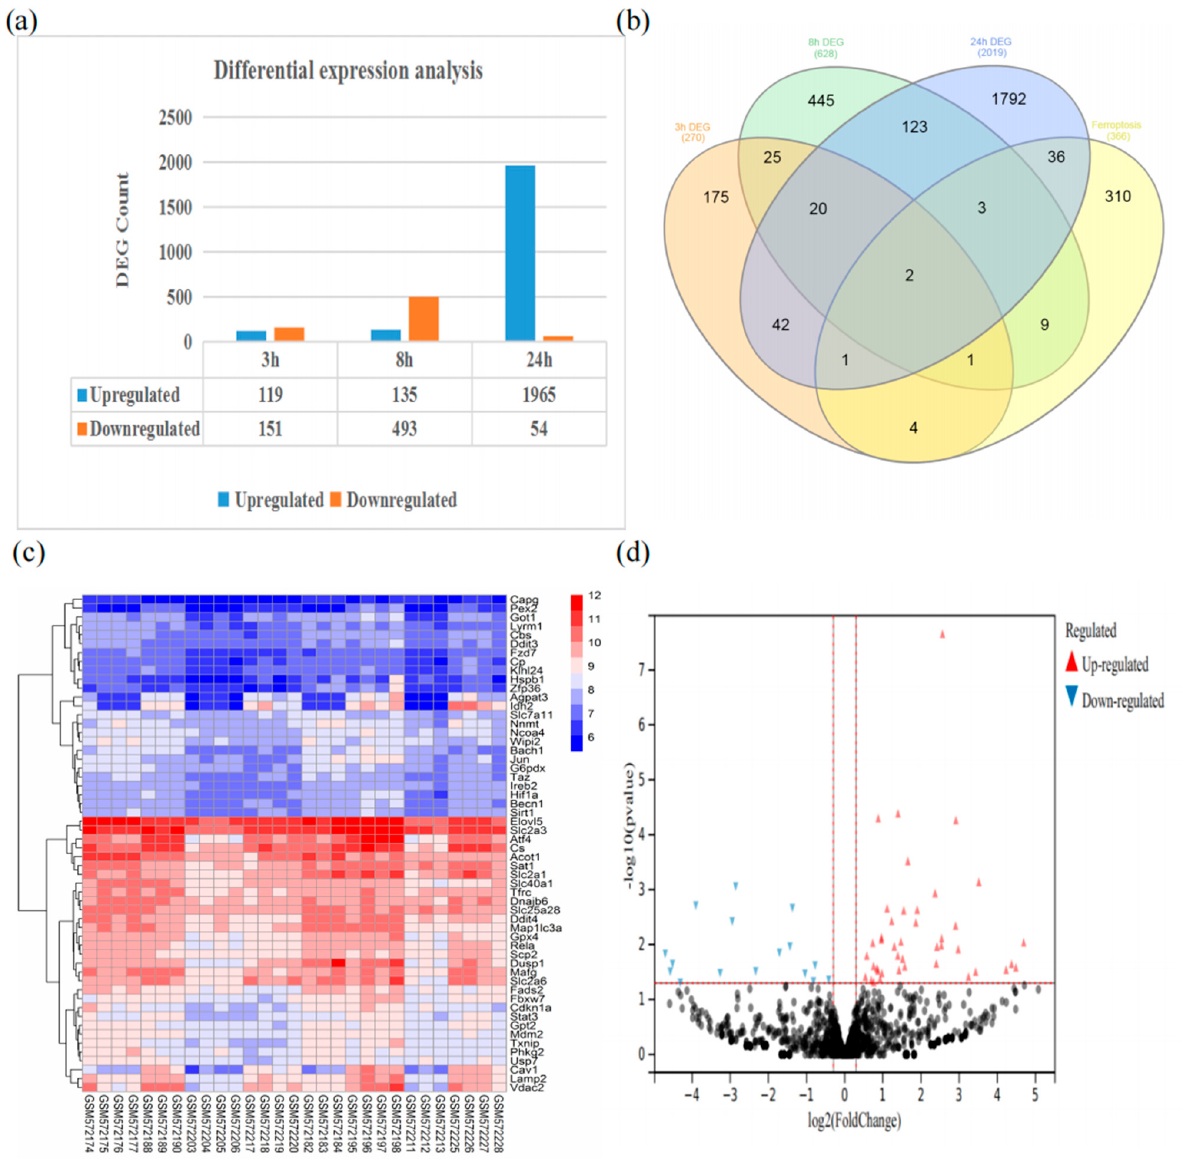
Figure 2. ( a ) Results of mRNA differential expression analysis; ( b ) Venn diagram of the relationship between DEGs at different times and ferroptosis-related genes; ( c ) Heat diagram of FRDEGs; ( d ) MiRNA differential expression analysis (black and gray dots represent miRNA with no significant differential expression).